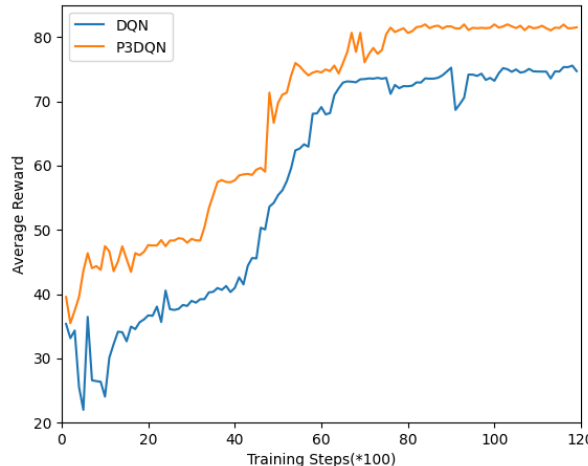
Figure 4. Reward with the training steps.